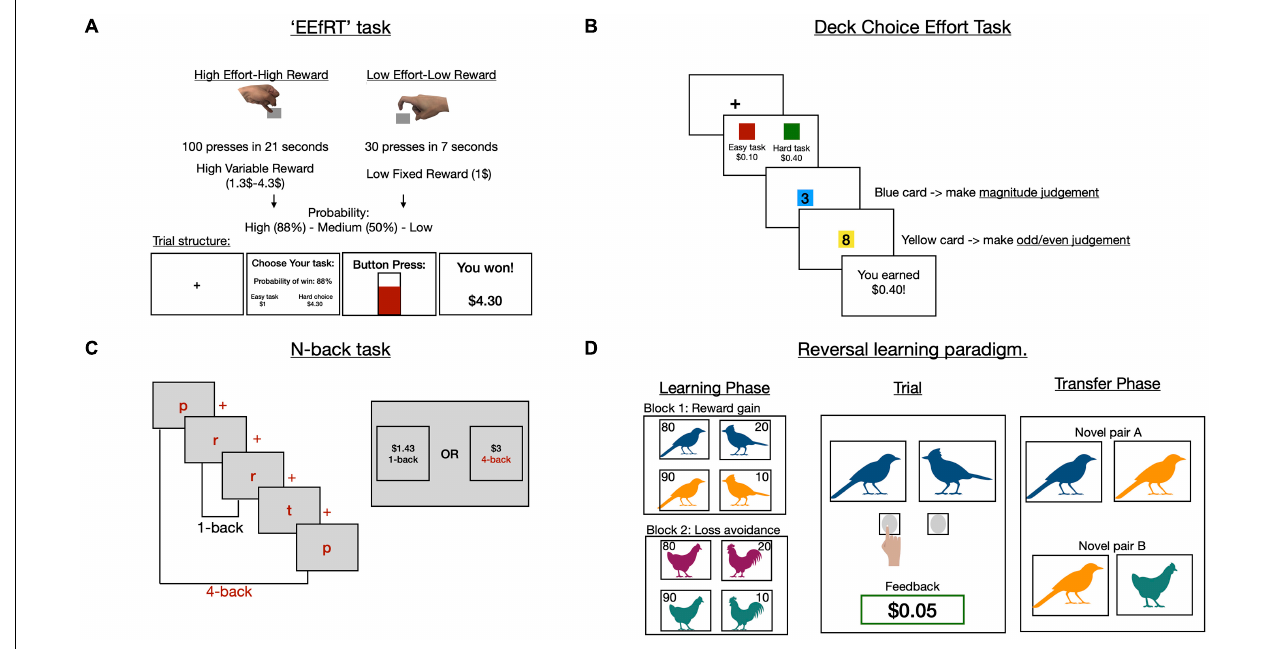
FIGURE 3 | Effort based decision making tasks in schizophrenia. Schematic representation of four paradigms (A–D) . The EEfRT task (A) varies physical effort in return for monetary reward. Participants choose between a high effort-high reward condition and low effort-low reward condition. Additionally, probability of winning varies across trial types. Adapted from Treadway et al. (2009). The deck choice effort task and the N-back task (B,C) both use cognitive instead of physical effort in a similar task structure to the EEfRT task, although probability is not varied. (B) In the deck choice task, high effort involves serially alternating between two mental activities, whereas only one mental activity is performed in the low effort option. (C) In the N-back task participants are serially presented with a list of letters and asked if the same letter was presented N steps back. They choose between a 1-back trial for low reward or a higher N-back (e.g., 4-back) for higher reward. (D) Learning paradigms involve choosing between two partially reinforced images to either gain reward, or avoid loss (see subsection “Reinforcement learning of reward value”). In a learning phase, only two images are presented per trial and one type of outcome is varied per block (reward gain vs. loss avoidance). A subsequent transfer phase uses novel combinations of visual stimuli to investigate learning behaviour across trial